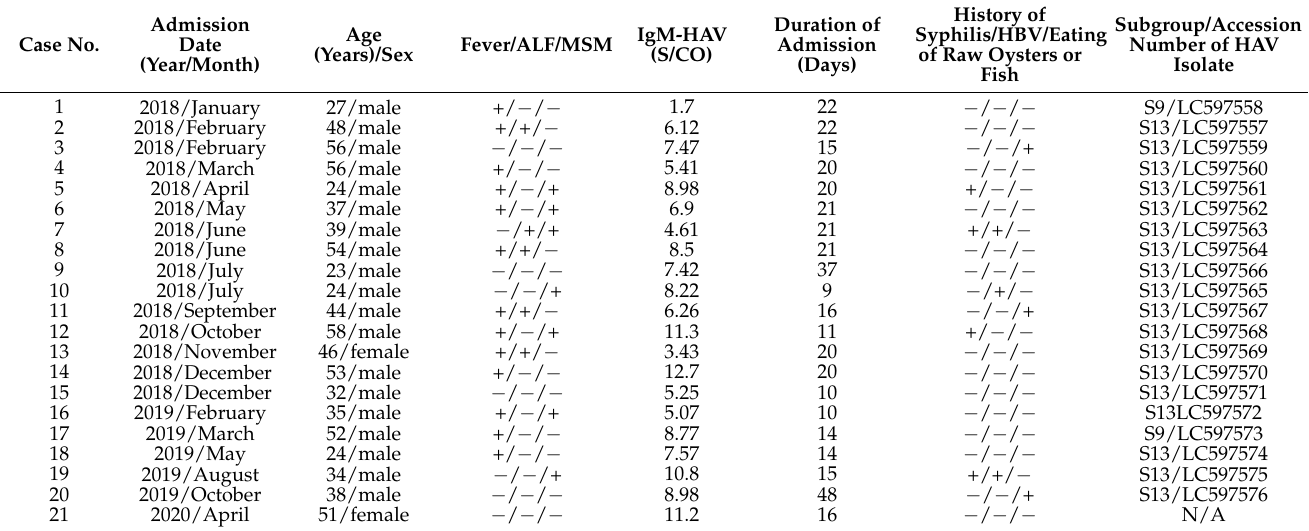
Table 2. Clinical features of the 21 patients with HAV subgenotype IA infection in the present